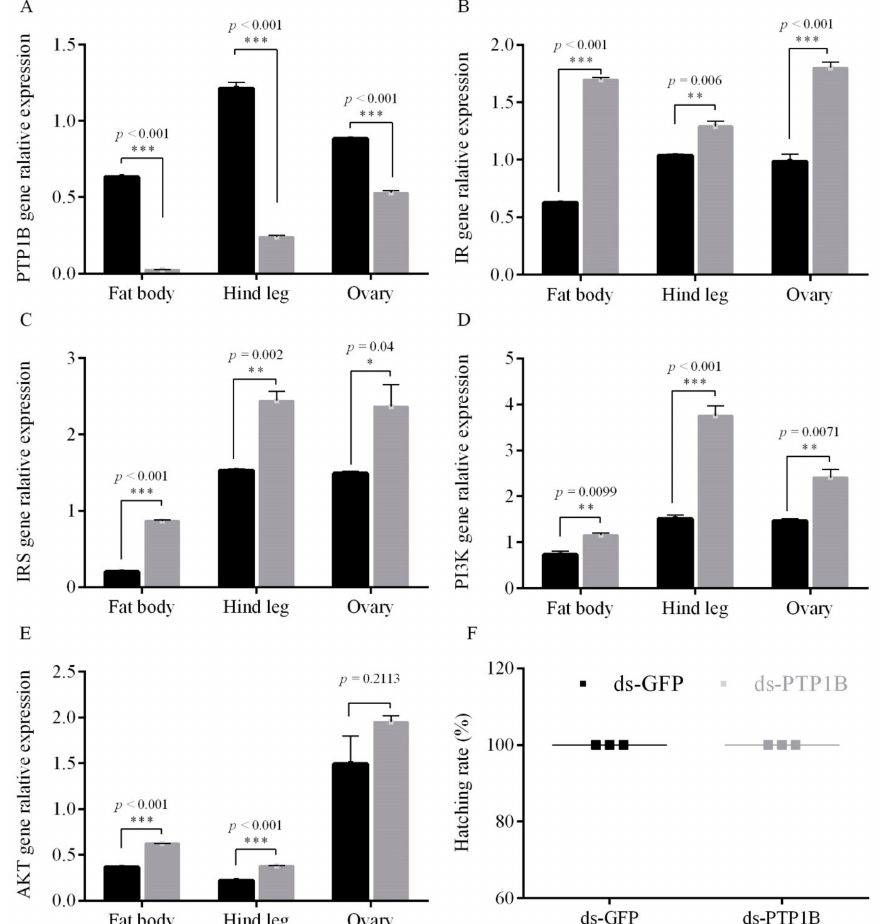
Figure A1. Gene relative expression and egg hatching incidence after injection of adults with RNAi PTP1B compared to injection with GFP (control) under long photoperiod conditions (L16:D8) for ( A ) PTP1B gene, ( B ) IR gene, ( C ) IRS gene, ( D ) PI3K gene, ( E ) AKT gene and ( F ) egg hatching incidence. Data are the mean ± SEM from three independent replicates, the gray bar indicates RNAi treatments, while the black bar indicates GFP controls (* p < 0.05, ** p < 0.01, and *** p < 0.001 vs. GFP controls, Student’s t -test).